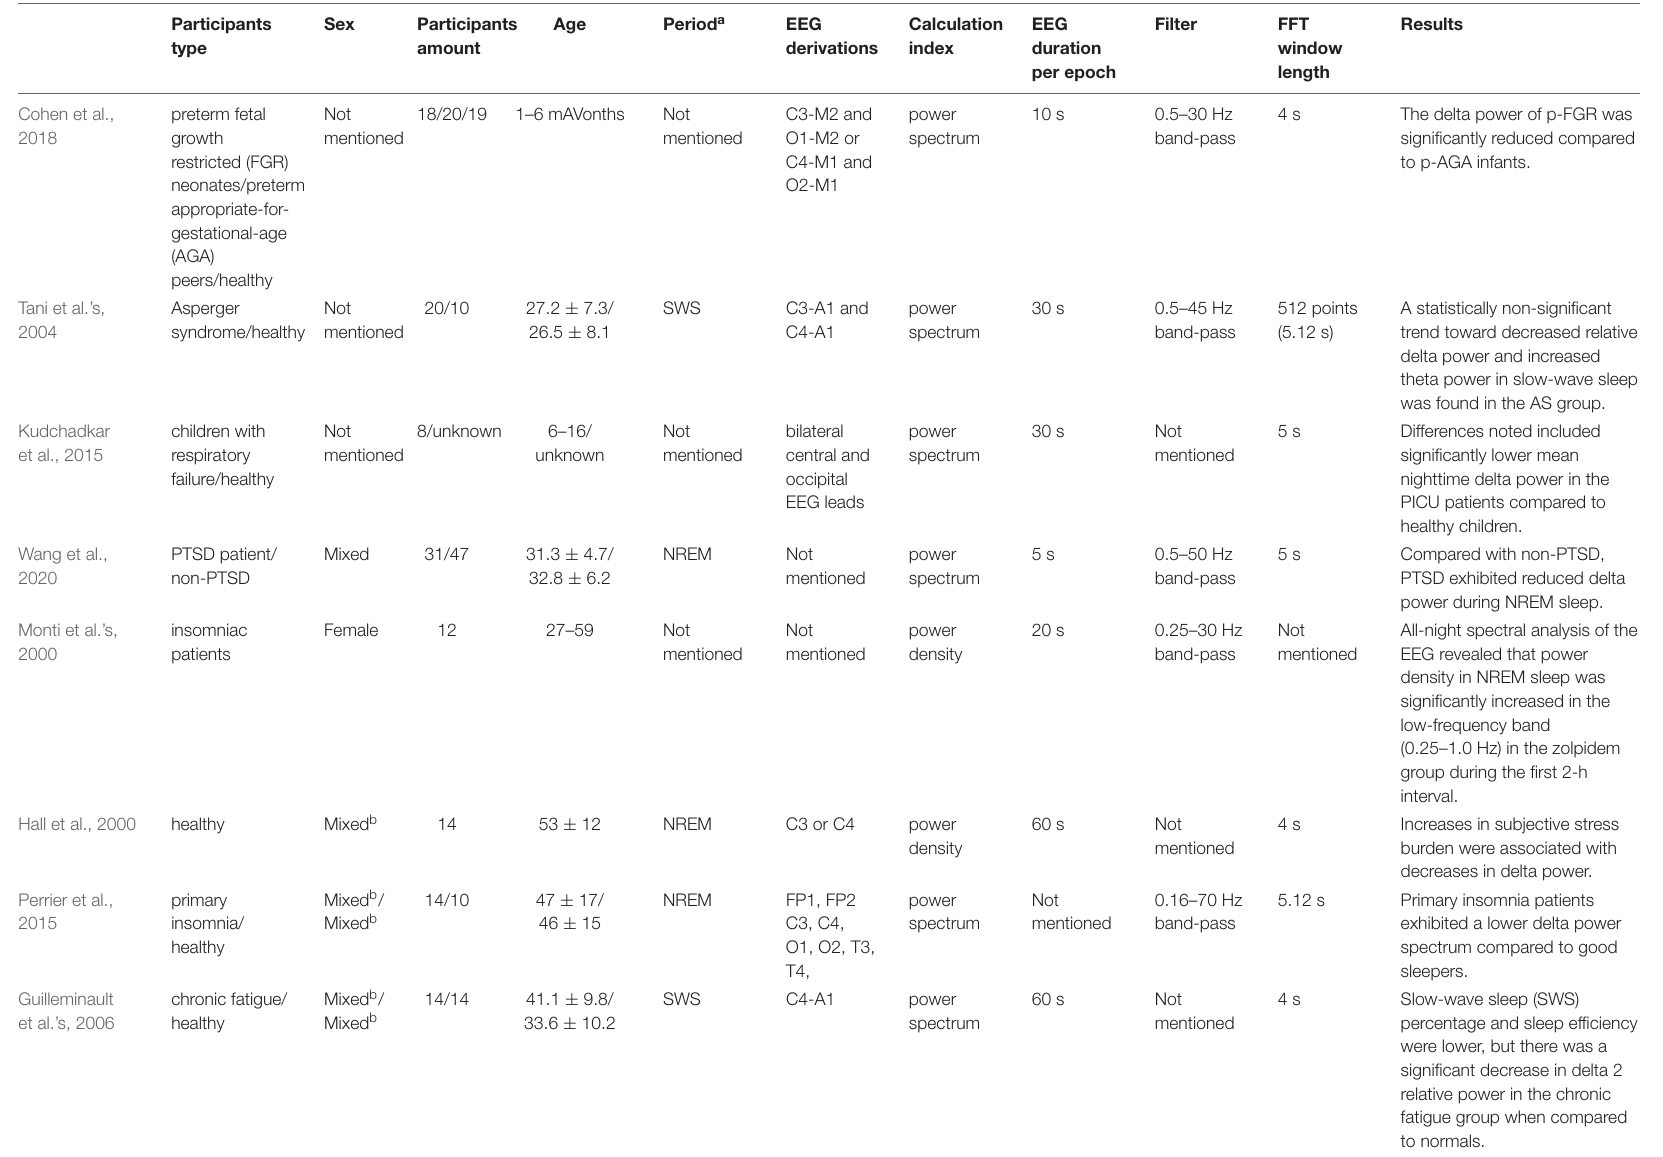
TABLE 2 | A delta power increase indicates better sleep in different